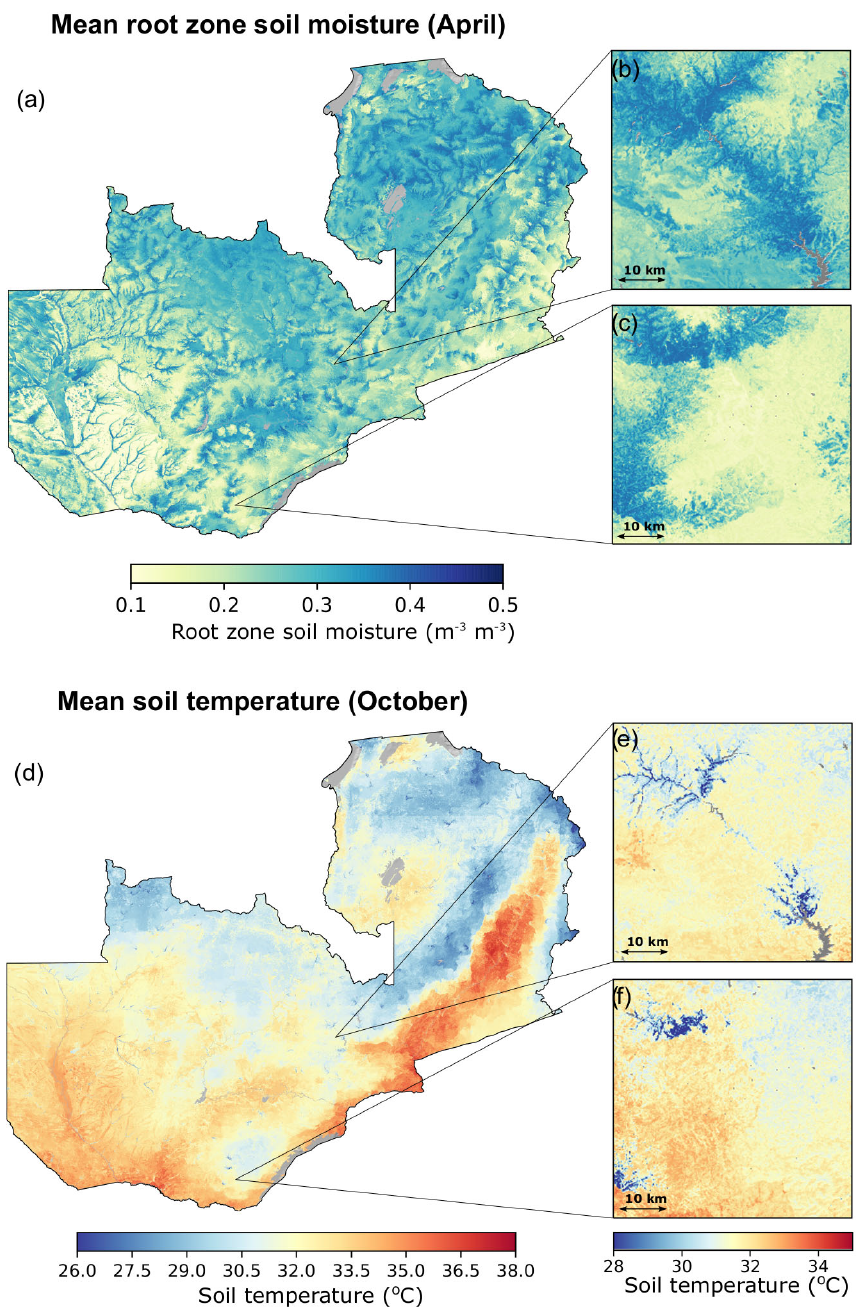
Figure 1. April root zone soil moisture and October soil temperature were the most predictive variables in the RF model. Panels (a) and (b) show respective mean values (2000–2018), at the 30m spatial resolution, as simulated by the HydroBlocks land surface model. Large lakes are excluded from the simulations (gray